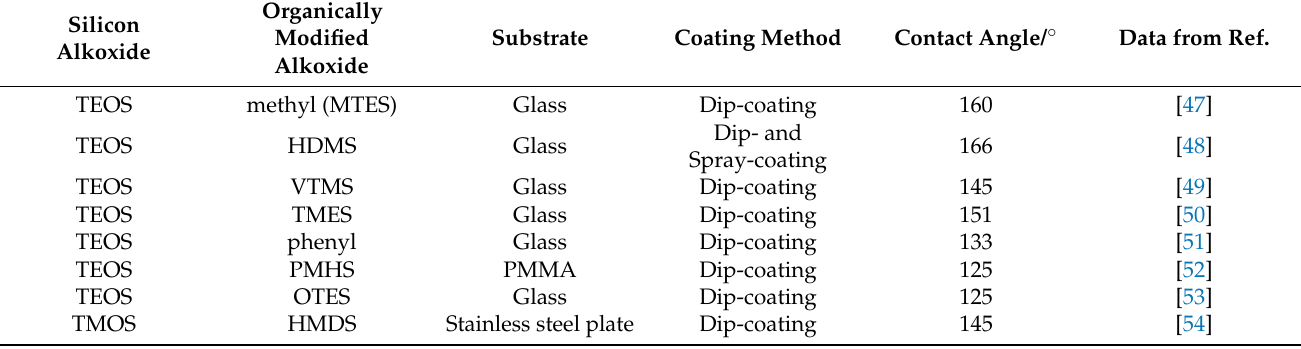
Table 1. One-pot syntheses of hydrophobic silica films.